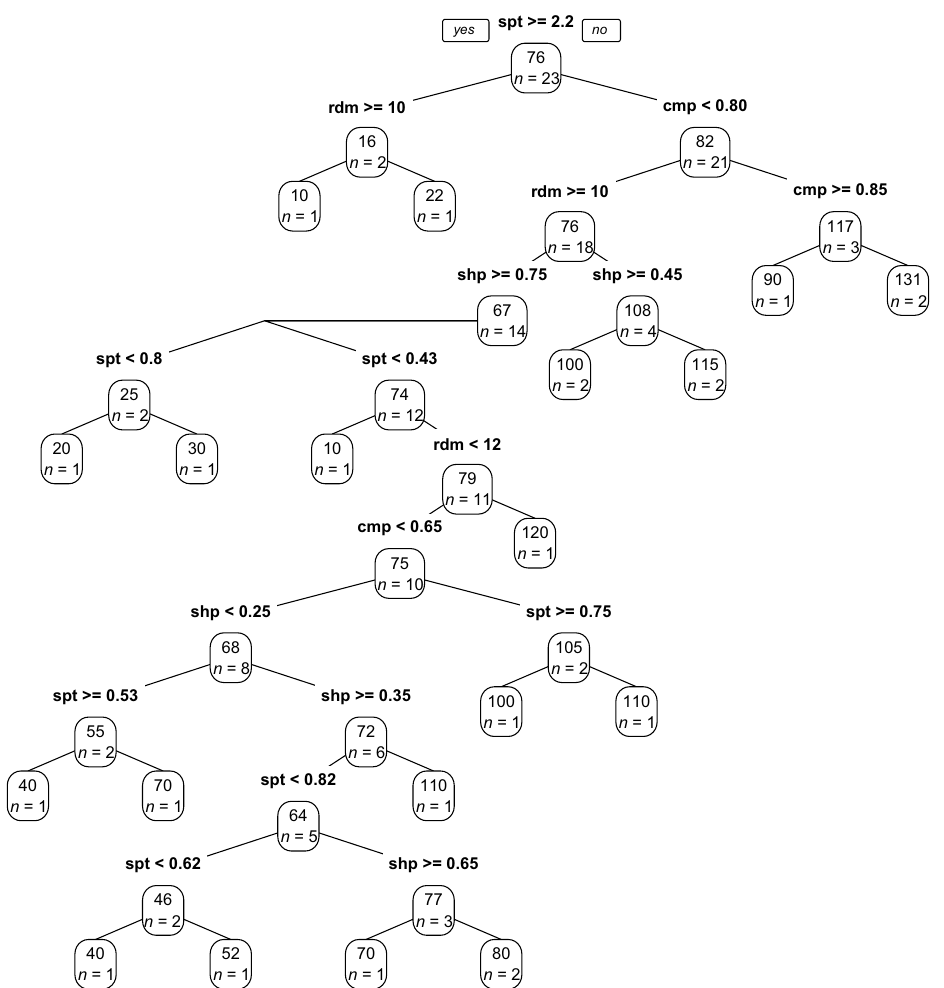
Figure A5. Graphical representation of the rulesets of the RT model established for the road class. Note: spt = spatial resolution, rdm = radiometric resolution, shp = shape/color weight, and cmp = compactness/smoothness weight, n = the number of samples at each node; the values in the rectangles are the estimated SPs.